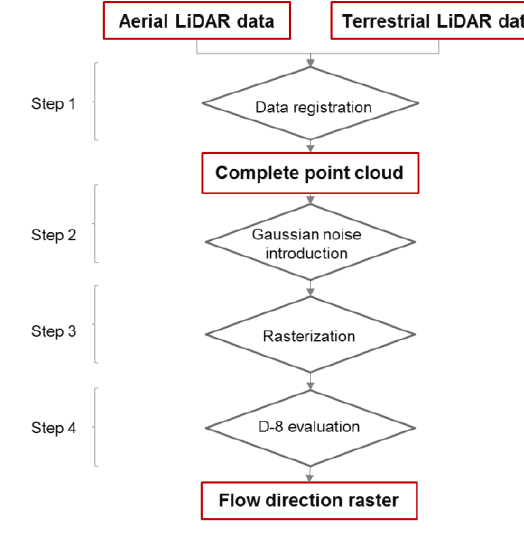
Figure 5. Schema of the proposed methodology.